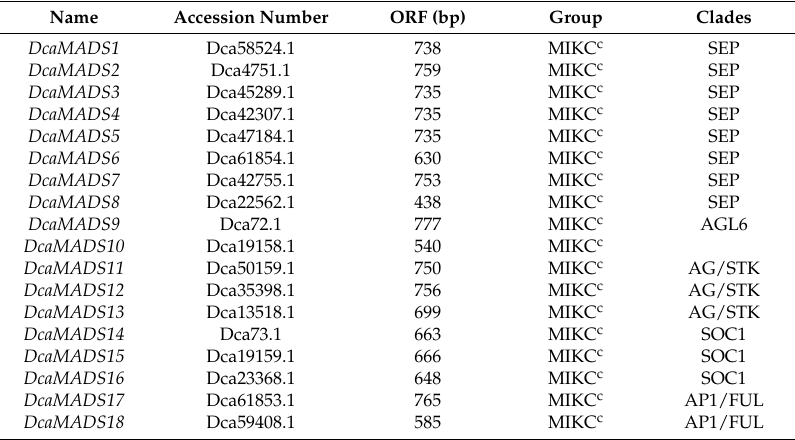
Table 1. The complete list of the carnation MADS-box